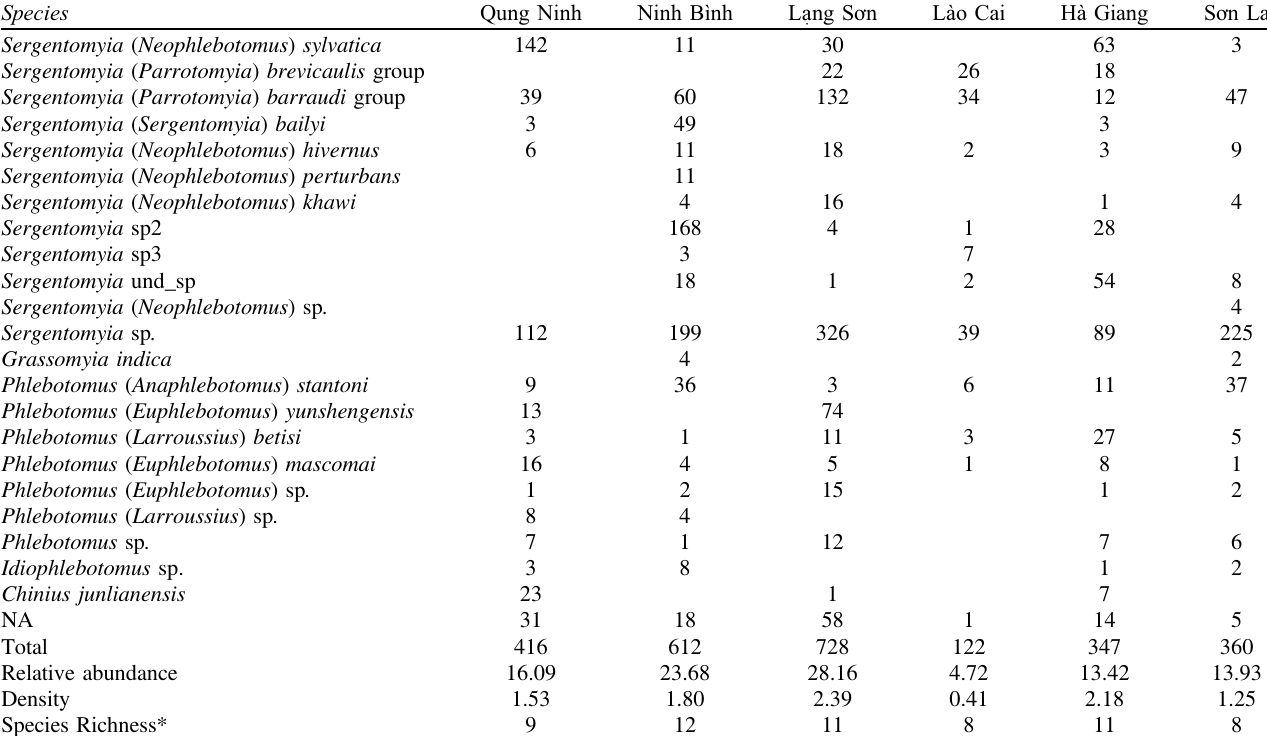
Table 2. Number of specimens per taxon, relative abundance, density and species richness per province Species Qung Ninh